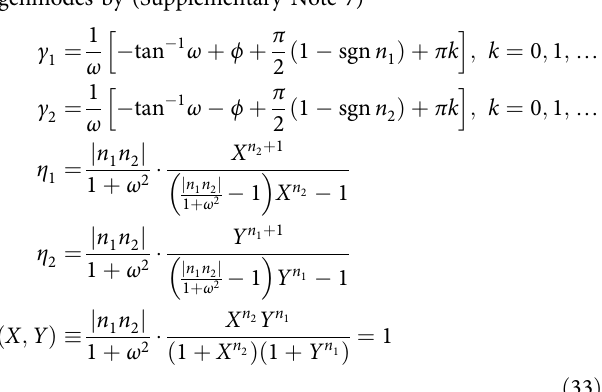
Fig. 7 Two-component autoregulatory loops reproduce behaviors of autoregulation, but have additional behaviors describing the relative dynamics of the components. a A two-component loop network motif, which is similar to autoregulation but with two explicitly modeled genes instead of one. b Parameter space of the two regulatory strength parameters showing phase diagram for a loop composed of two activators (cross-activating) or two repressors (cross-inhibitory). Shading shows results of simulations (with an interval of 0.1 for both γ and η axes); blue curve is the analytically derived phase (bifurcation) boundary from Eq. (32). c Parameter space varying both strength parameters. Because the Hopf bifurcations depend only on the total delay and transient oscillations most prominent for equal delays, we show only the cases γ 1 = γ 2 . Blue curves show analytically derived Hopf bifurcations. Black dashed curves are the bifurcation boundaries from ( b ). Except for the activator/repressor case, all these curves lie above the bistability boundary given by the black curve in ( b ), meaning oscillations are always transient. d Representative simulations for speci fi c initial conditions showing all possible qualitative behaviors for a two-component loop with two activators, two repressors, or one activator and one repressor. For two-activator bistability and oscillations, a second set of initial conditions is shown in dashed lines to demonstrate the bistability. Hill coef fi cients equal 2 for repressors, − 2